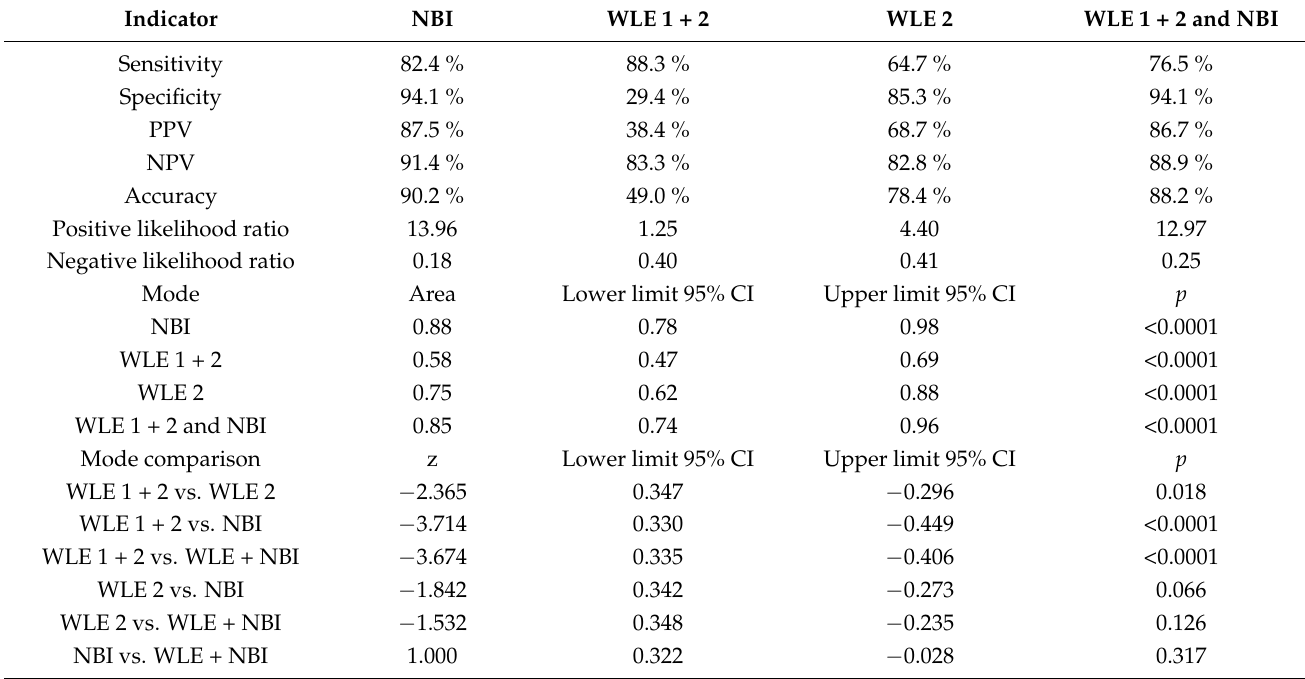
Table 3. Sensitivity, specificity, positive predictive value (PPV), positive negative value (PNV), accuracy and likelihood ratio of the four diagnostic modalities applied in group